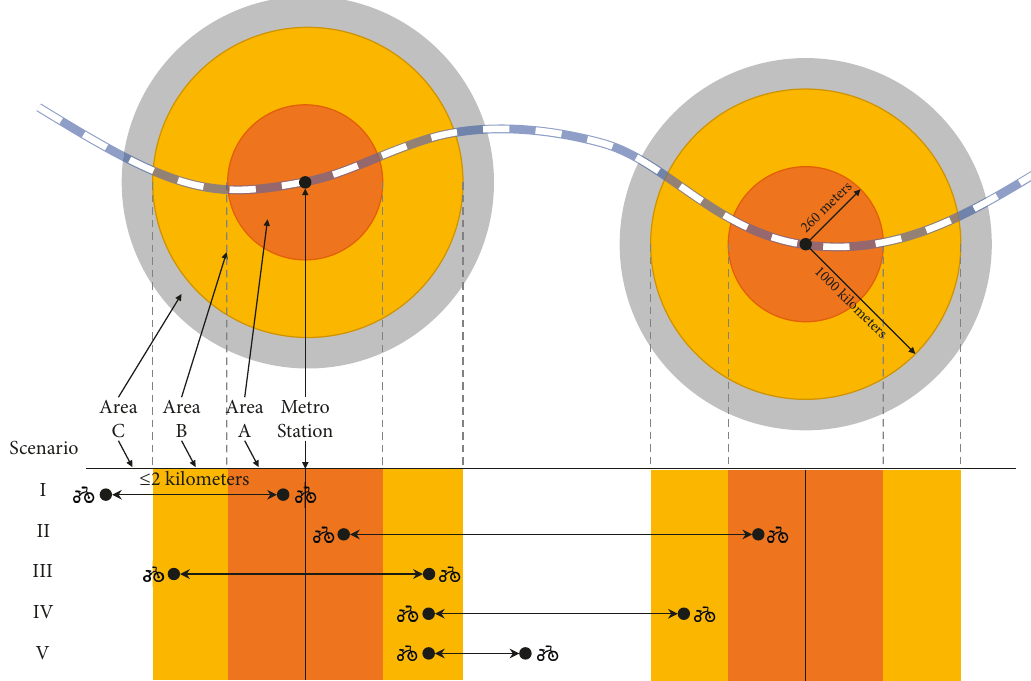
Figure 5: Illustration of the five